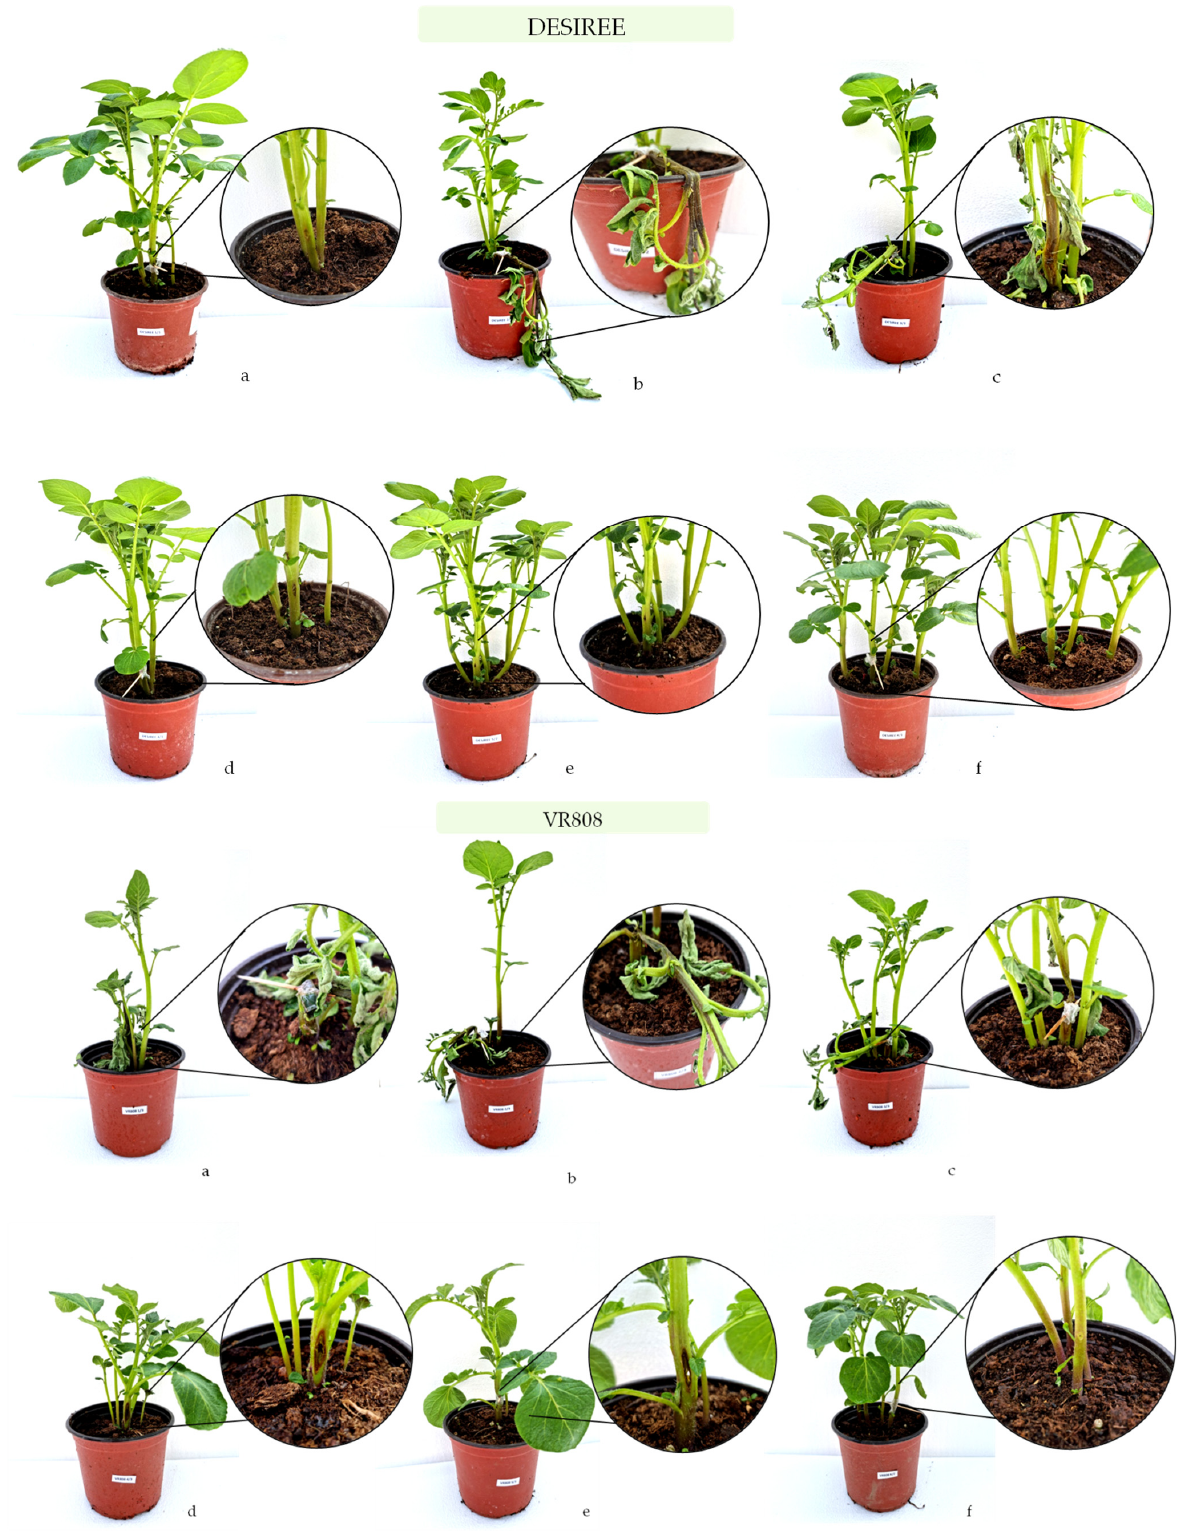
Figure 5. Blackleg and stem wilt symptoms registered 48 h post inoculation on cv. Desiree and cv. VR808 inoculated with ( a )- P. brasiliense strain MMKC19, ( b )- P. carotovorum strain MMDC11, ( c )- P. punjabense strain MMZCVR2, ( d )- P. carotovorum strain DAPP-PG 752, ( e )- P. brasiliense strain LMG 21370, ( f )-negative